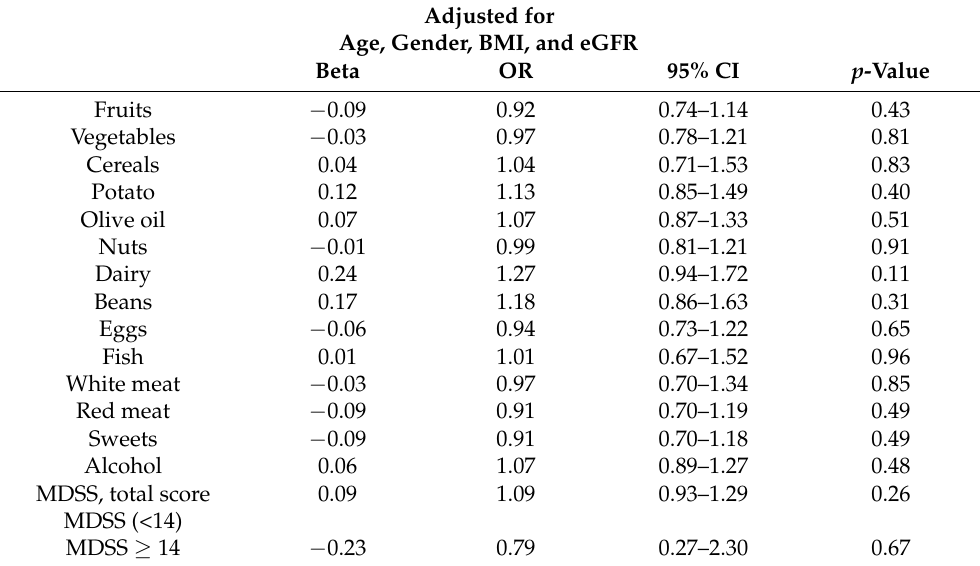
Table 5. Association of food intake adherence according to MeDi and MDSS score with risk of development of CKD in